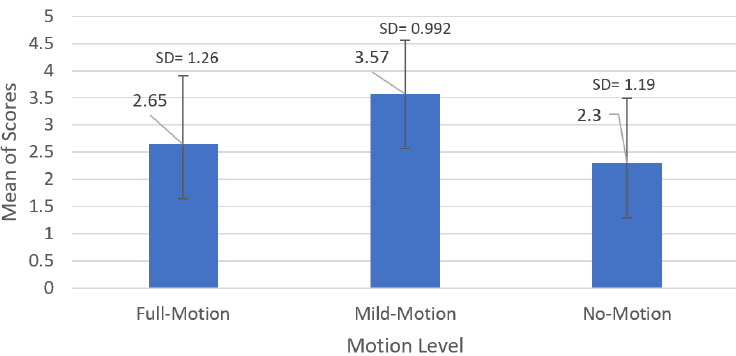
Figure 10. Mean scores given by the participants to the different levels of the motion platform’s cues.